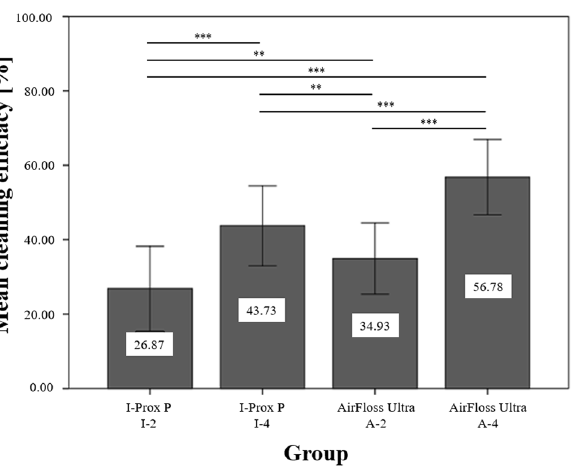
Figure 4. The mean total cleaning efficacy (in percent) with the standard deviation of the I-Prox P brush for two seconds (I-2) and four seconds (I-4) and the AirFloss Ultra with 2 sprays (A-2) and 4 sprays (A-4). Horizontal lines with “***” show significant differences between the devices with p < 0.001, and “**” indicates a significant difference with p < 0.01.